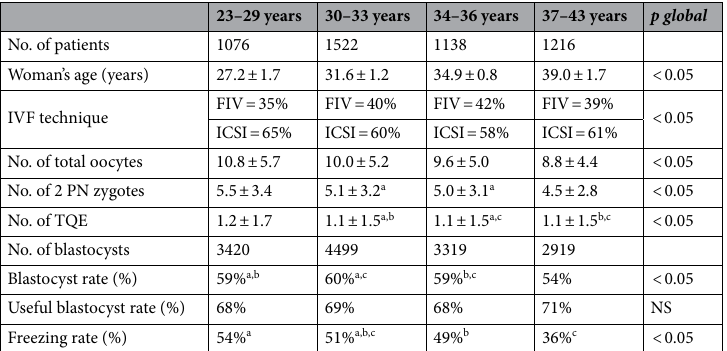
Table 1. General characteristics and biological outcomes in the age groups of women. Numbers are expressed as mean ± standard deviation. Values with the same superscript letters are not significantly different ( p > 0.05). No. number, NS non-significant, PN pronucleus, TQE top-quality